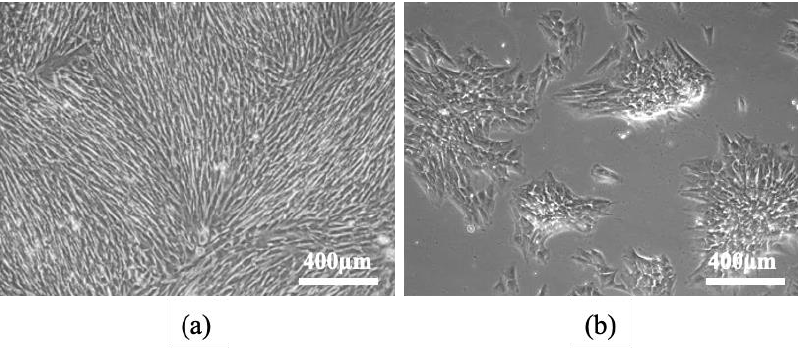
Figure 4. eSM-MSCs in culture, isolated through enzymatic digestion: ( a ) Passage 0 (P0); ( b ) Passage 1 (P1). Plastic adherence, monolayer, and fibroblast-like shape of eSM-MSCs may be observed. Magnification, 100 × .